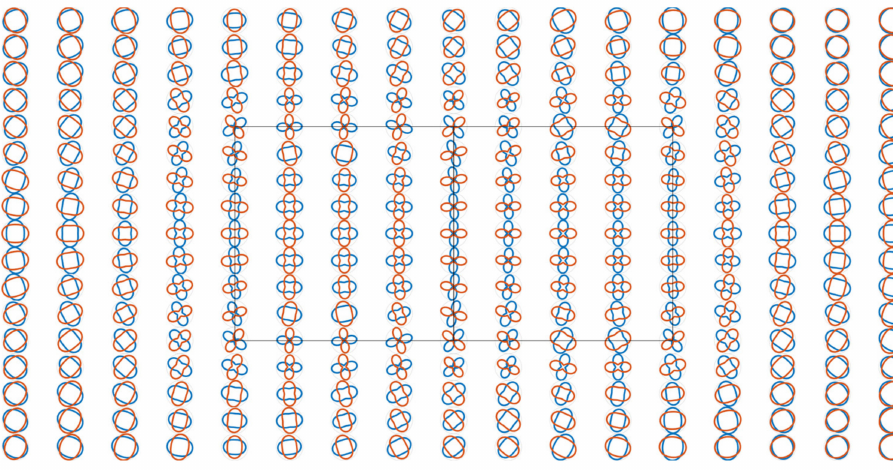
Figure 20. Polar plots of COMMEMI 3D-2A model for a frequency of 0.001 Hz.